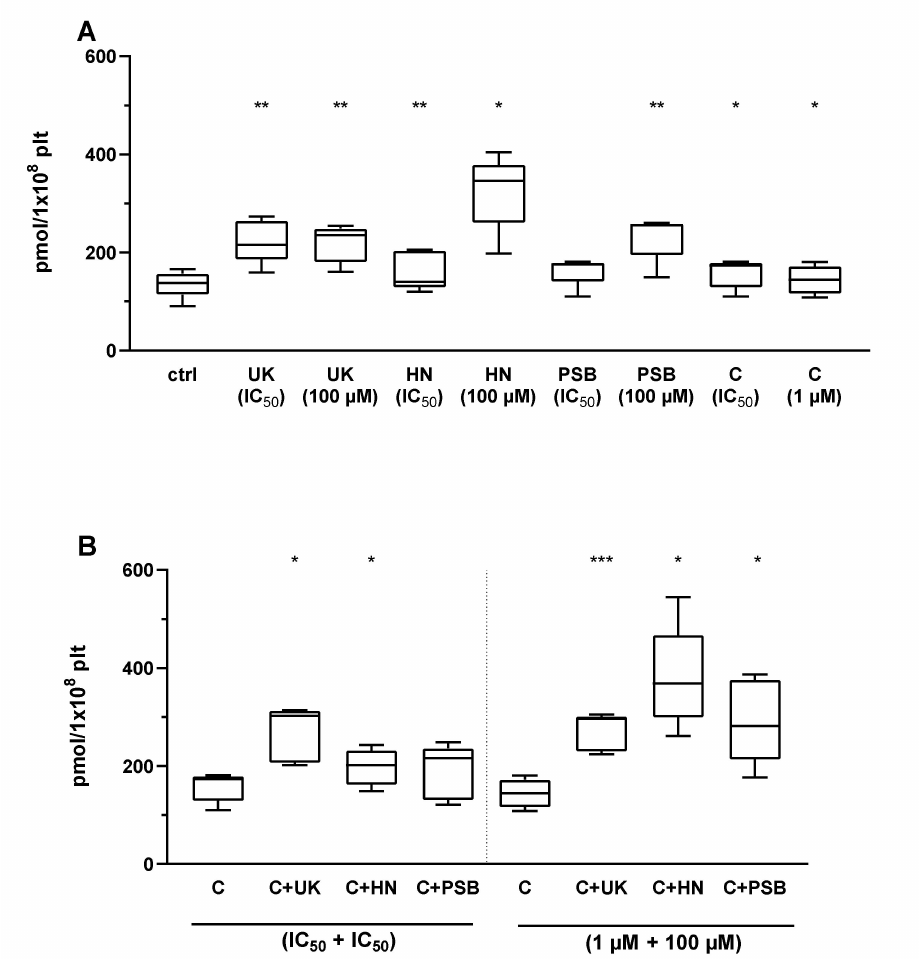
Figure 6. AR agonists strengthen the P2Y 12 inhibitory e ff ect on platelet reactivity as measured by cAMP formation in resting platelets ( n = 5). Panels present data on AR agonist impact on platelets in comparison to unstimulated platelets (ctrl) ( A ), platelets antagonised with P2Y 12 inhibitor: cangrelor ( B ). Data are presented as median, interquartile range (box), and minimum and maximum values (whiskers). cAMP level was measured in isolated platelets. Samples were preincubated at 37 ◦ C for 3 min with AR agonist and cangrelor. Statistical significance estimated by one-way ANOVA for repeated measurements with the post hoc Bonferroni’s multiple comparisons test or Friedman’s test with Dunn’s correction for multiple comparisons (samples containing AR agonist are compared to control samples with P2Y 12 inhibitor within pertinent group). * p < 0.05, ** p < 0.01, *** p < 0.005.